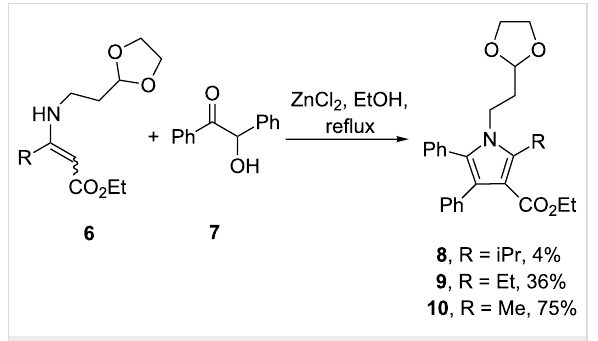
Scheme 1: Synthesis of pentasubstituted pyrroles.